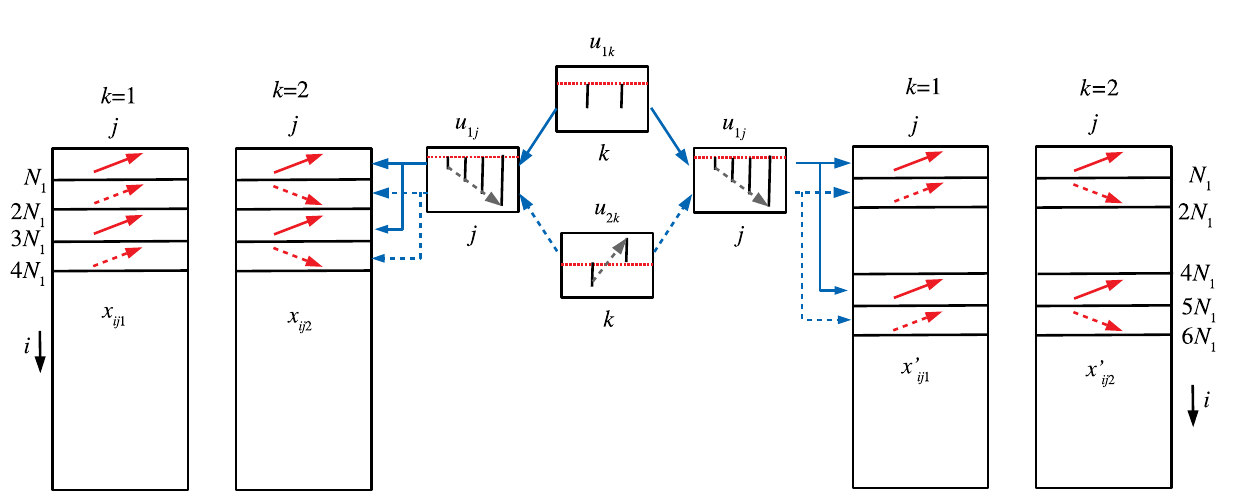
. The horizontal red broken line 1